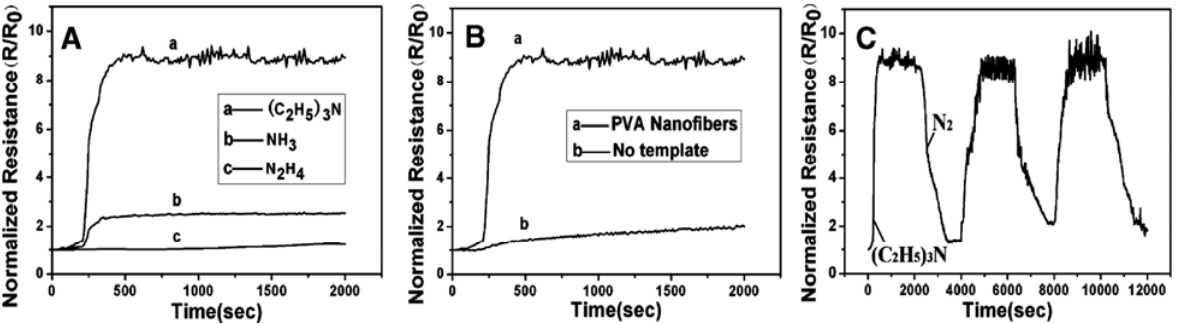
(NH , N H , and (C 3 2 4